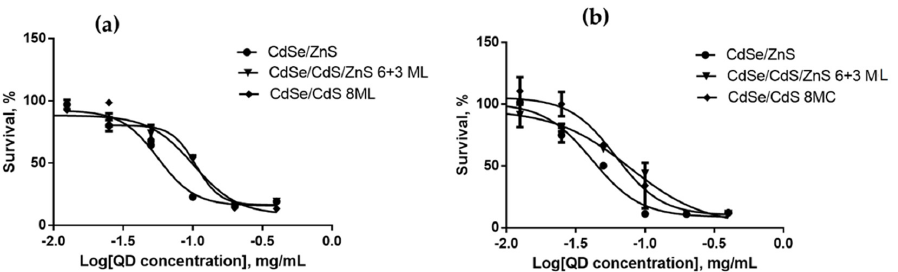
Figure 4. Survival of WI-38 cells upon interaction with CdSe/ZnS-PEG-OH, CdSe/CdS/ZnS (6+3 ML)-PEG-OH, and CdSe/CdS (8 ML)-PEG-OH QDs for ( a ) 24 and ( b ) 48 h as dependent on the QD concentration.